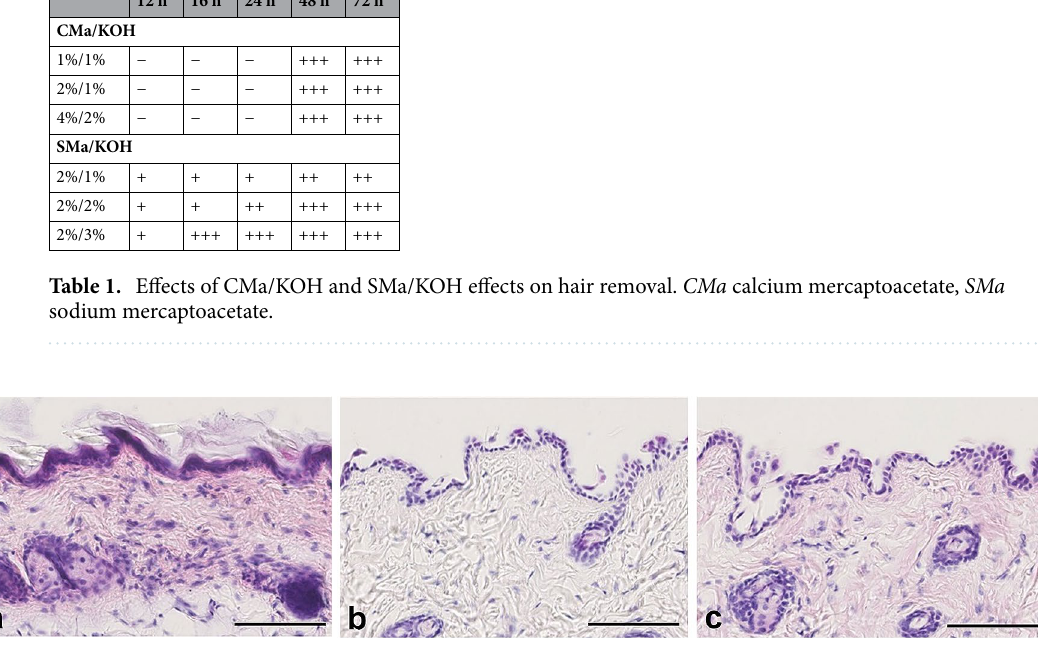
Figure 2. Skin histological changes following hair removal treatment (HE staining). The stratum corneum remained in the control skin ( a ; incubated with distilled water at 42 °C for 16 h). By contrast, the corneum was removed by the hair removal treatment (b and c; incubated in a mixture of 2% sodium mercaptoacetate and 3% KOH at 42 °C for 16 h). However, the hair removal treatment was not affected by the dermal histological structures. The skin after hair removal showed less eosinophilic property throughout the section, particularly in collagen fibers of the dermis ( b ). However, the eosinophilic property was restored by ethanol acetate immersion before staining ( c ). Scale bars: 100